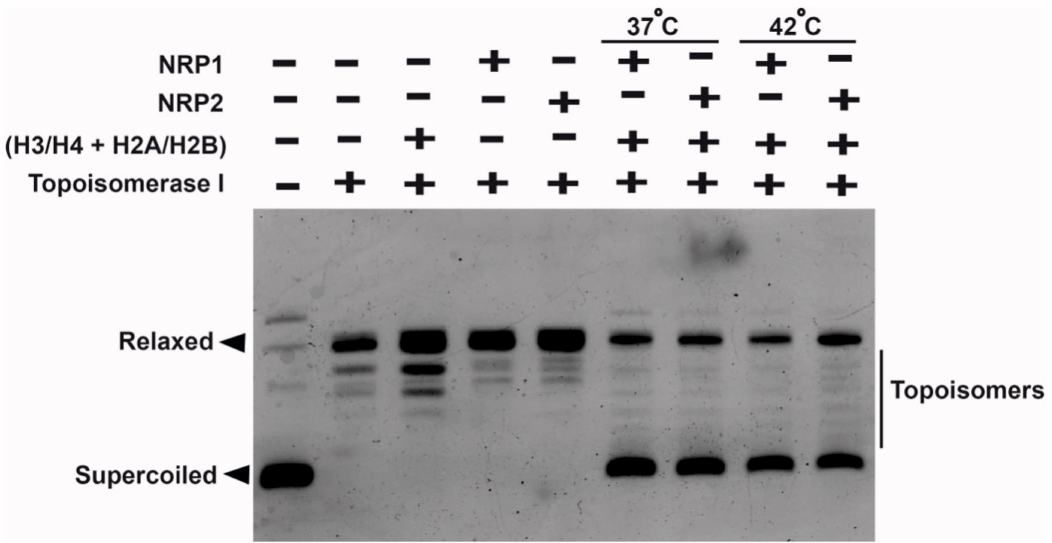
Figure 10. Plasmid DNA supercoiling assay. The plasmid DNA supercoiling activity was carried out for full-length forms of both AtNRP1 and AtNRP2. The samples were run on 1% agarose gel and stained with ethidium bromide. Relaxed and supercoiled forms of plasmids are labeled in the figure. Topoisomers are the plasmid DNA bands corresponding to di ff erent degrees of supercoiling, due to the e ff ect of histone